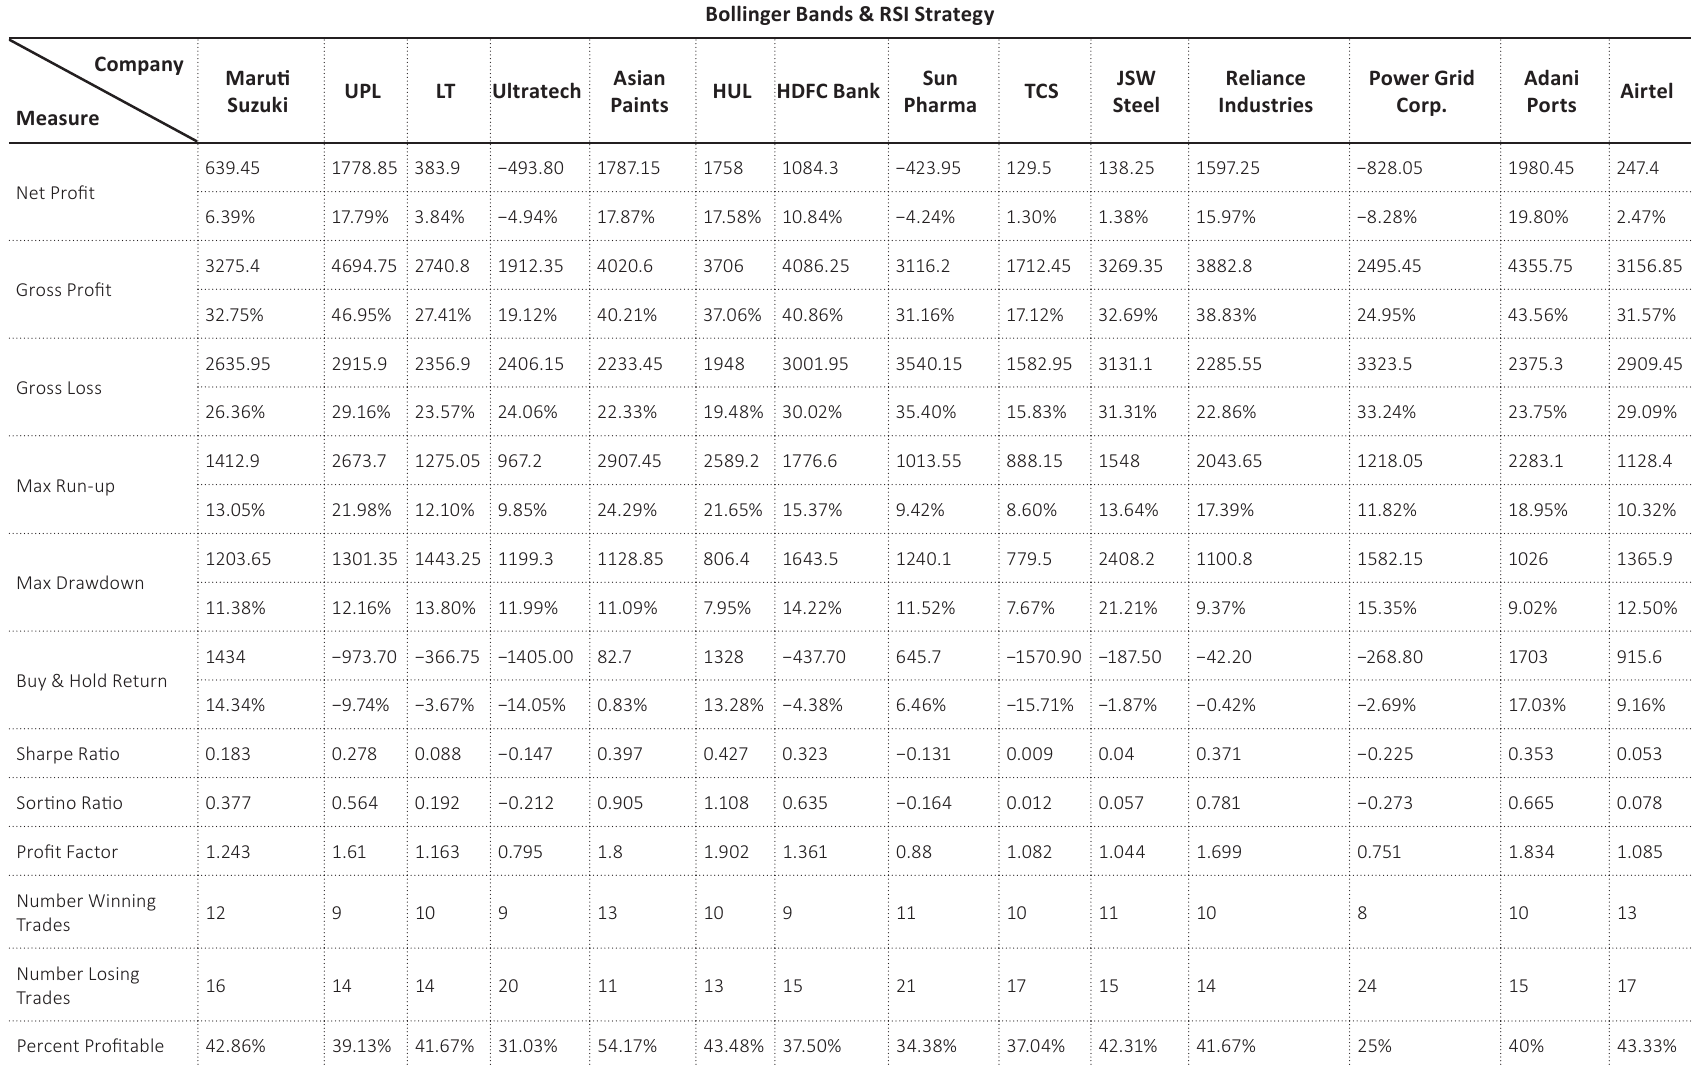
Table A4. Bollinger Bands and RSI Strategy results